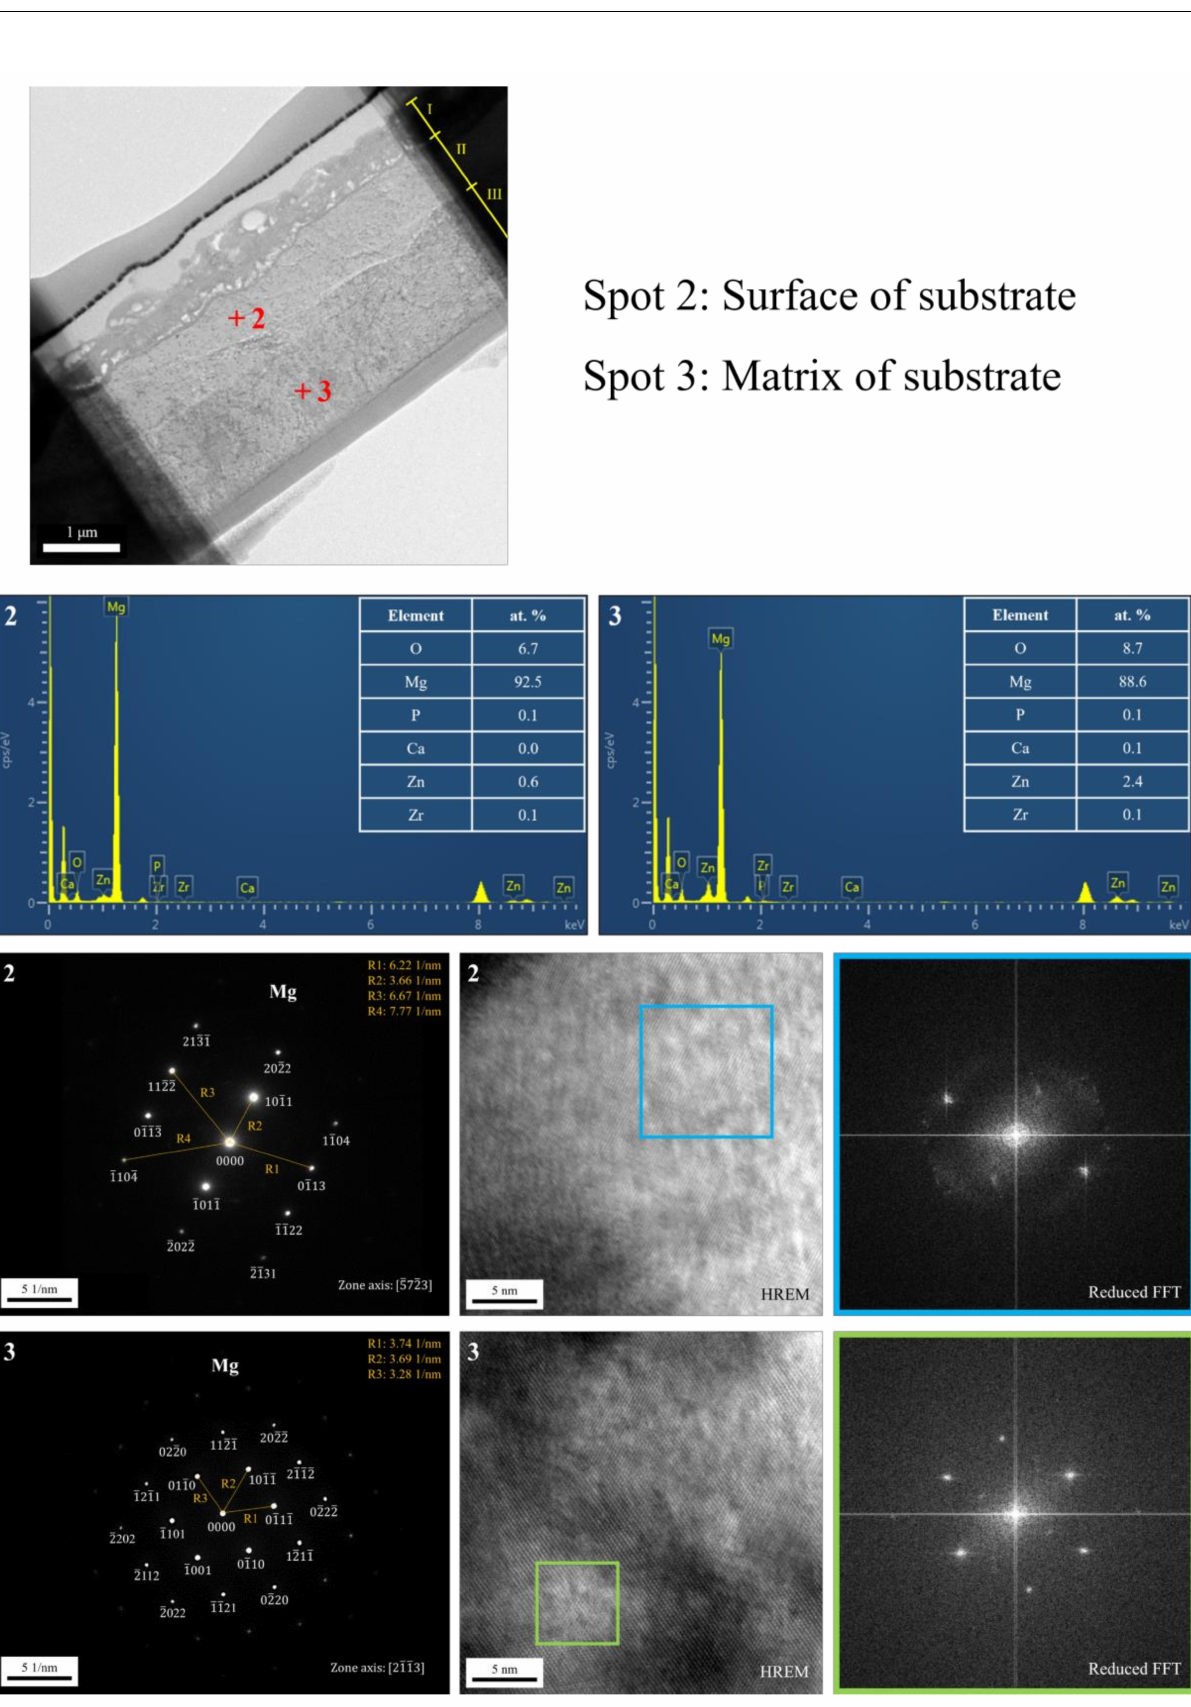
Figure 8. TEM analysis of the substrate after anodic